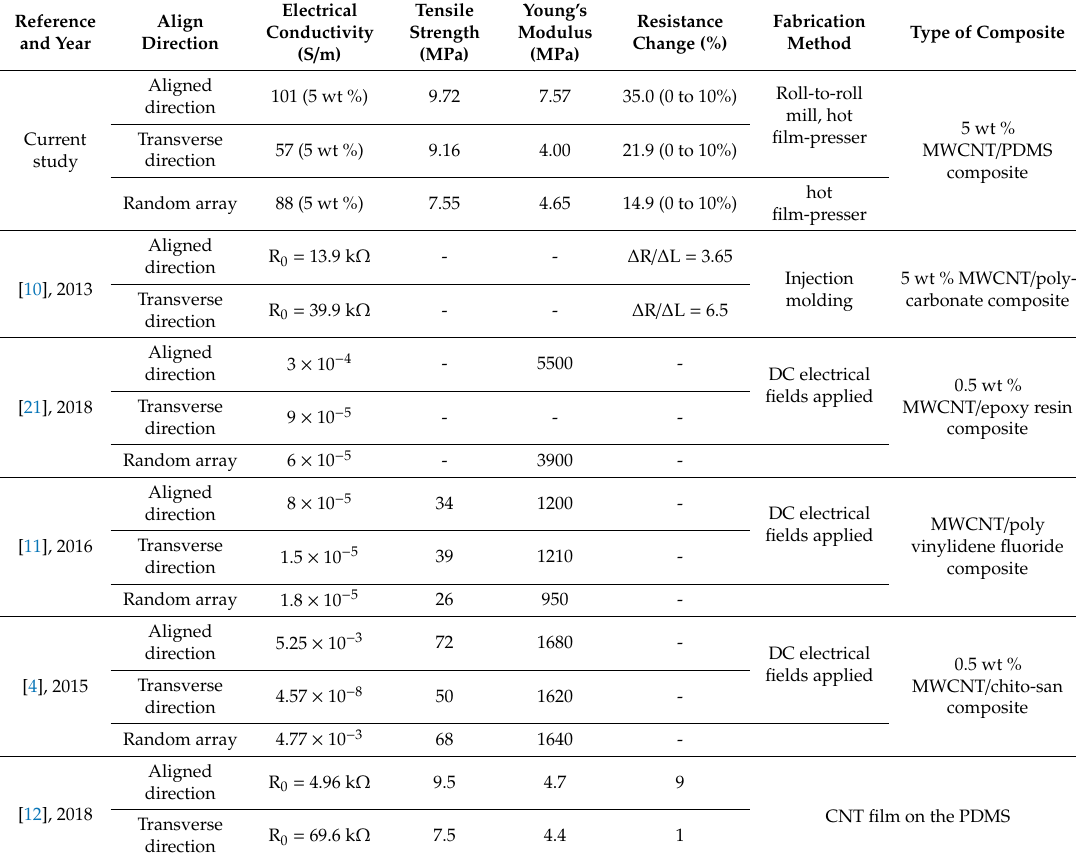
Table 2. Electrical, mechanical properties and piezo-resistive characteristic during tensile stress of CNT / polymer based composites fabricated by various